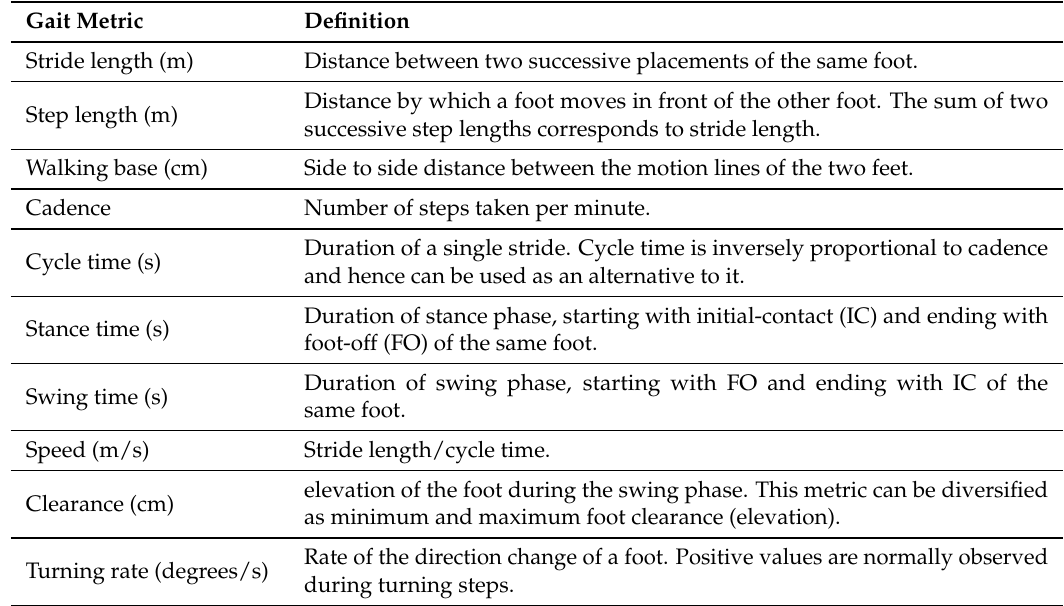
Table 1. Spatio-temporal gait